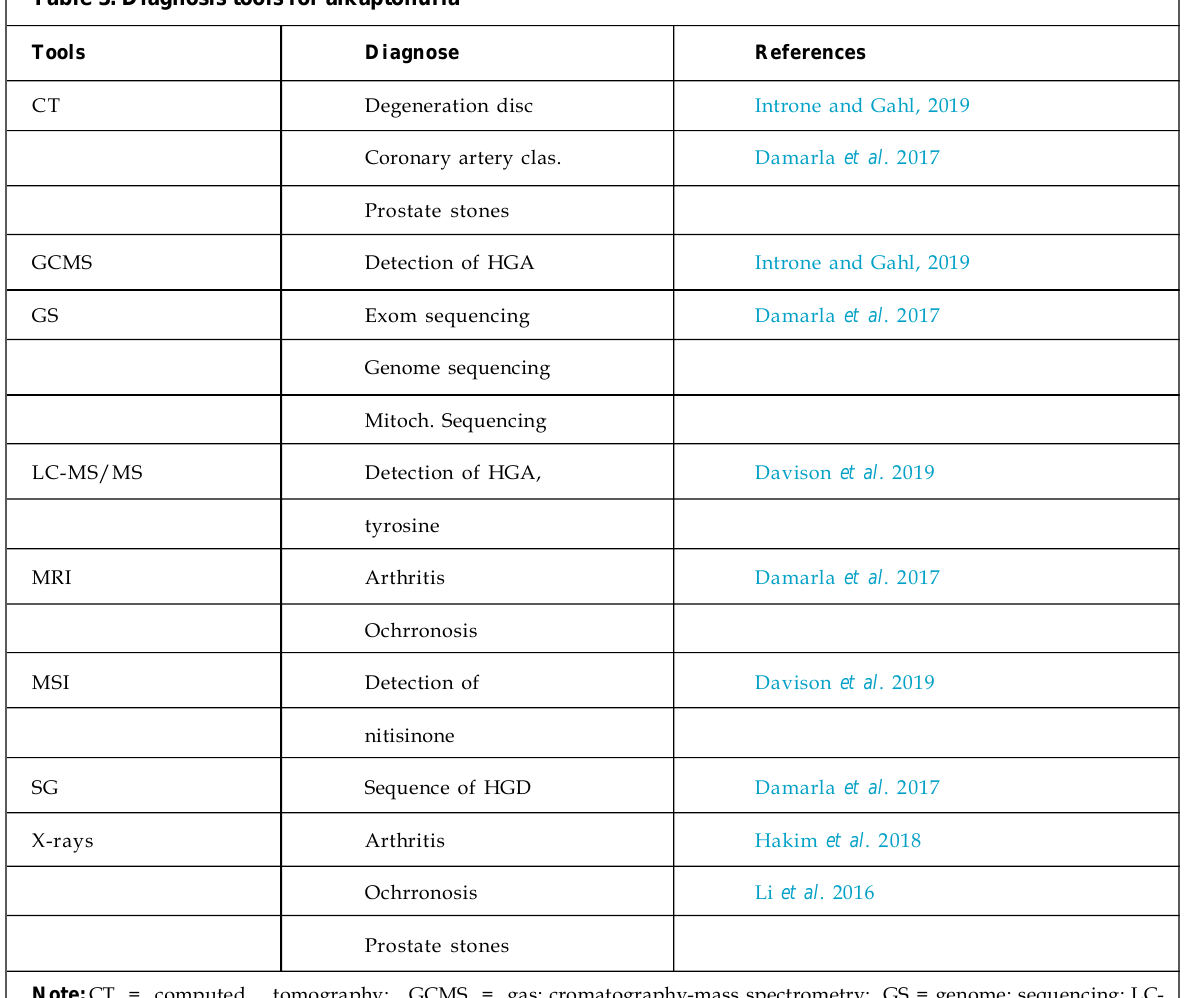
Table 3: Diagnosis tools for alkaptonuria